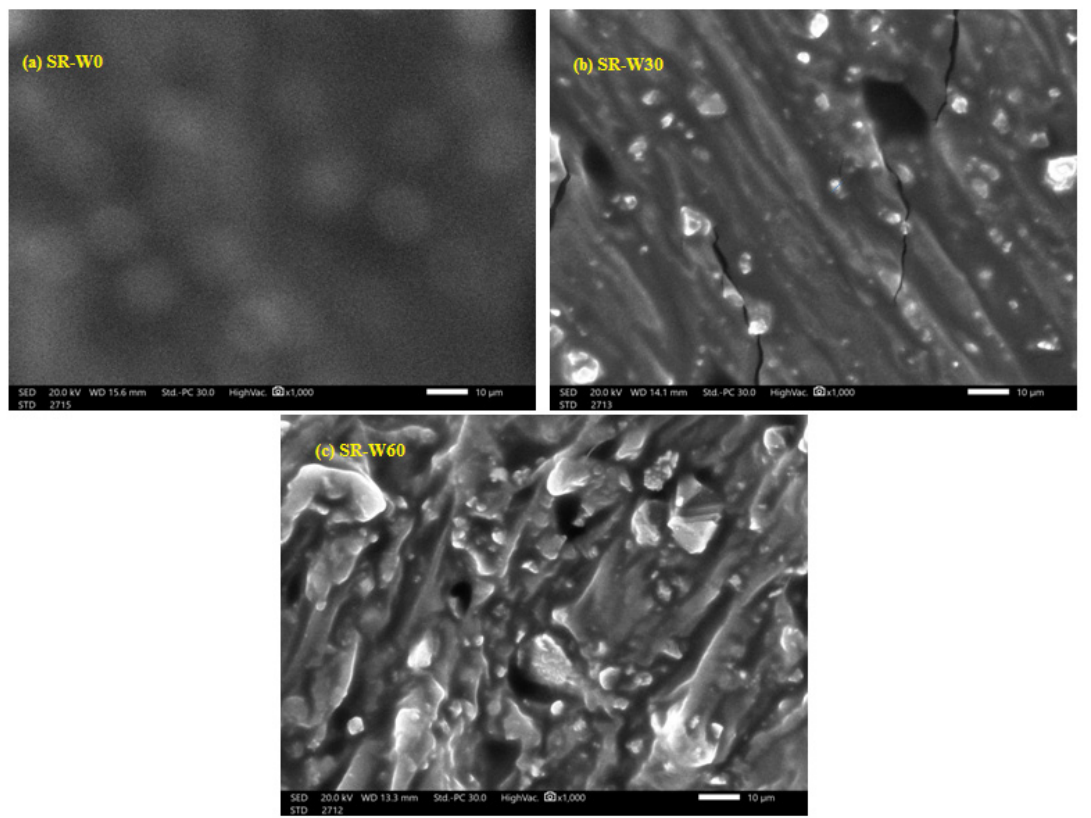
Figure 6. SEM images of ( a ) SR-W0, ( b ) SR-W30 and ( c ) SR-W60. The fractional transmission (ln(I/I 0 )) versus the thickness (cm) of silicone rubber (SR) systems with different concentrations of WO 3 -nanoparticles for energy 0.0595, 0.662, 1.173, and 1.333 MeV have been publicized. The slope representing the most fitting straight line considering these data are of utmost importance as LAC has been displayed through the slope of the line obtained after scheming the fractional transition values ln(I/I 0 ) versus thickness of the absorbing materials (considering Lambert_Beer’s law). Herein, an increase in the energy causes an increase in the I/I 0 and this means that the photons with high energy can penetrate the prepared silicone rubber easier than the photons with low energy. The negative value of the slope revealed that the transmitting value declined according to the enhancement of the absorbers’ thickness. A typical figure (Figure 7) has been presented here with the most fitting straight-line view with the slope value of 5.50126 denoting the linear attenuation coefficient (cm − 1 ) at 0.06 MeV. It is most convenient to attain mass attenuation coefficient (MAC) through the normalization of LAC by the density of that material. MAC has been found to be 2.33 gm/cm 2 through normalizing the LAC (5.50126 cm − 1 ) by the density (2.37 gm/cm 3 ) of the prepared silicone rubber (SR-W60), and it is notable that the